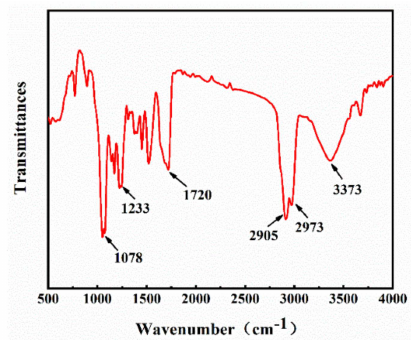
Figure 1. FTIR spectra of pure waterborne